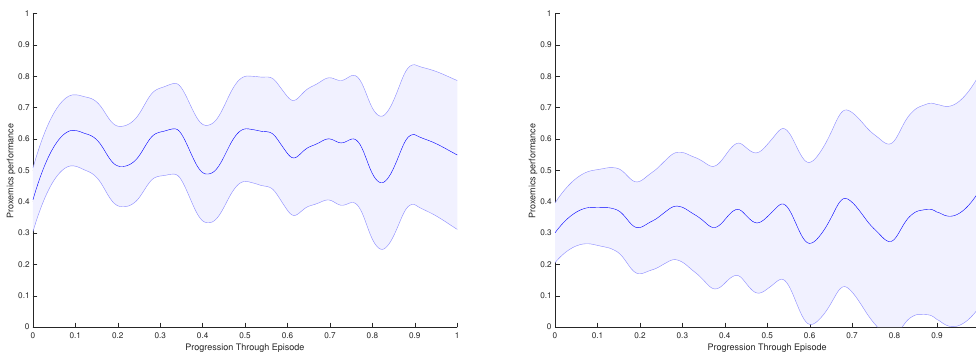
Figure 13. Real-life experiment with a person: Evaluation Results of the model through proxemics so- cial distances as presented in Section 6. ( Left ): Environment with no obstacles. ( Right ): Environment with one